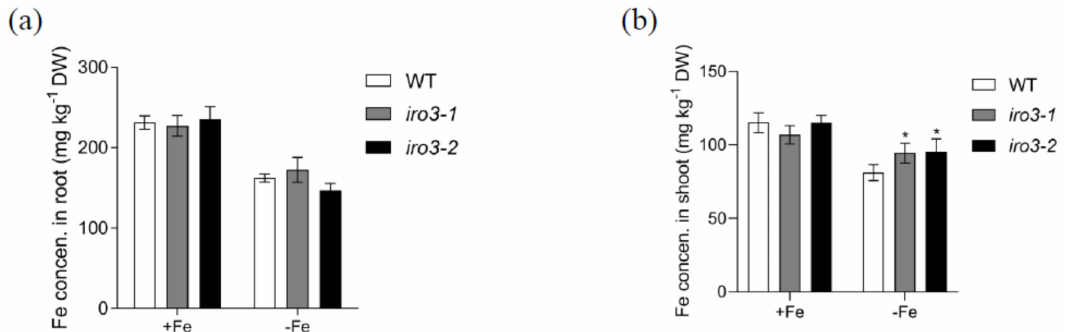
Figure 4. Fe concentration in WT and iro3 mutants. ( a ) Root and ( b ) shoot Fe concentration of WT, iro3-1 , and iro3-2 under + Fe or − Fe conditions. Fourteen-day-old seedlings of WT, iro3-1, and iro3-2 were transferred to nutrient solution containing 0 or 50 µ M Fe (III)-EDTA and grown for 8 d. Root and shoot Fe content of WT, iro3-1 , and iro3-2 were analyzed. Data are given as the means ± SD of four biological replicates. All data were compared with the WT. Significant di ff erences from the mutant and WT are indicated by * p < 0.05, as determined by two-tailed Student’s t